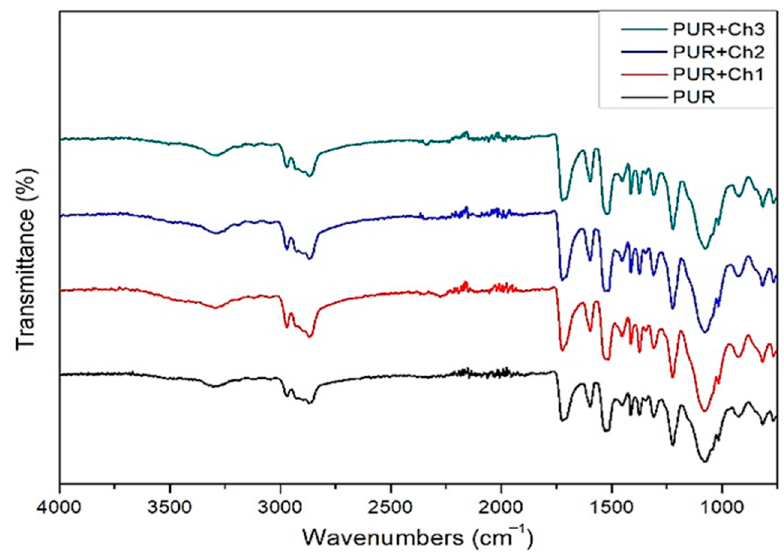
Figure 2. ATR-FTIR Figure 2. ATR-FTIR spectra.